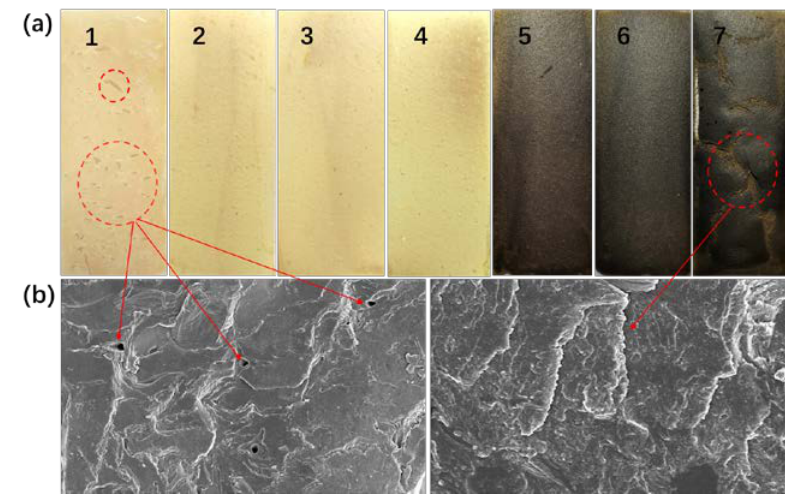
Figure 6. Crack observations ( a ) and SEM images ( b ) of cured adhesives. Table 3. The solid content and moisture uptake of investigated adhesives.